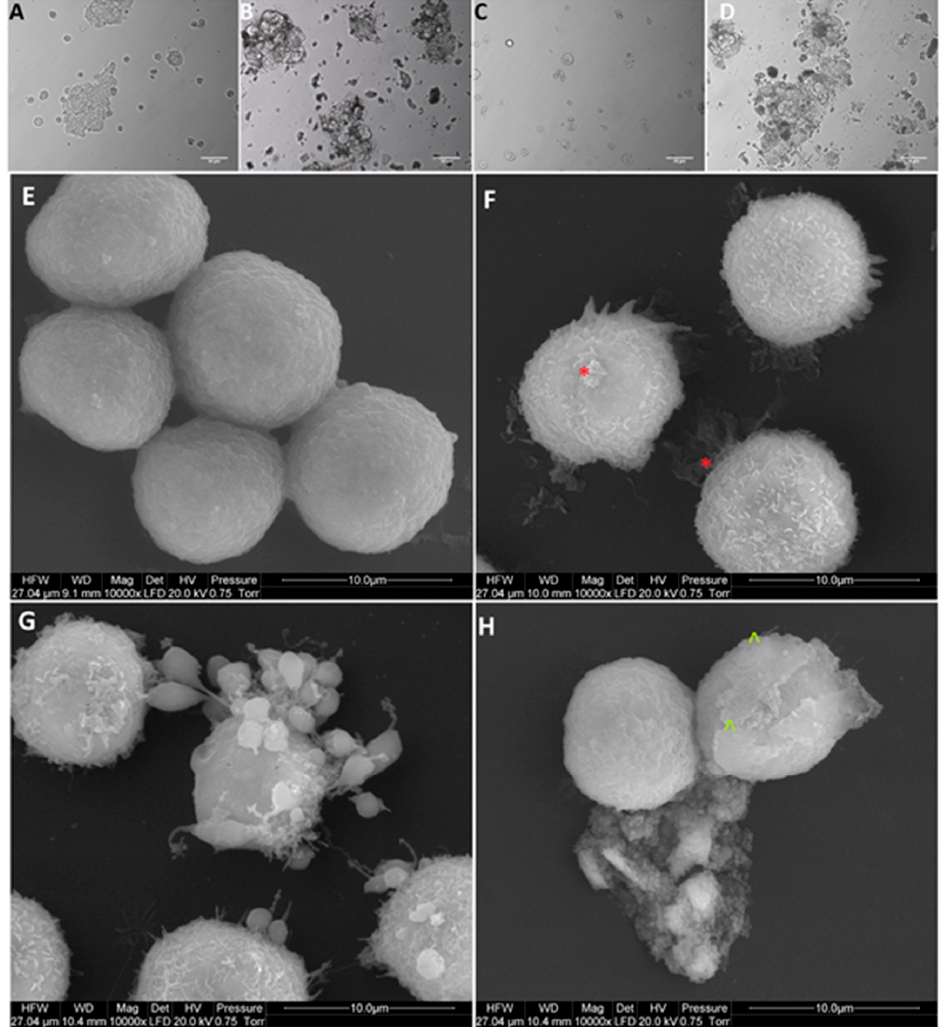
Figure 5. Morphology of Colo205 colorectal cancer cells. ( A , E ) untreated cells (control group), ( B , F ) cells treated with nanocomplexes of graphene oxide with platinum nanoparticles (GO-NP-Pt), ( C , G ) cells treated with platinum nanoparticles (NP-Pt) t, ( D , H ) cells treated with graphene oxide (GO). Red * —point on GO-NP-Pt at cell membrane. Green ˆ —point on GO at cell membrane. ( A – D ) Light optical microscopy. Scale bars: 50 µ m. ( E – H ) Scanning electron microscopy. Note: Scale bars: 10 µ m. Abbreviations: GO-NP-Pt—nanocomplexes of graphene oxide and platinum nanoparticles, NP-Pt—platinum nanoparticles, GO—graphene